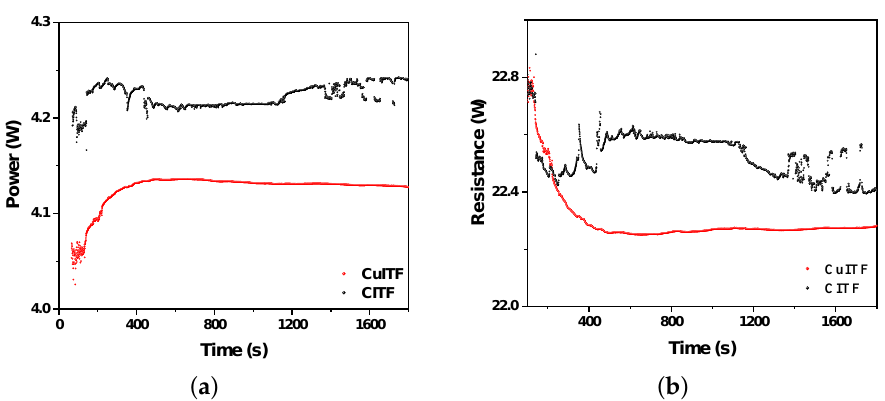
Figure 9. ( a ) Electrical power dissipation as a function of time in both furnaces. ( b ) Electrical resistance variations resistance as a function of time in both